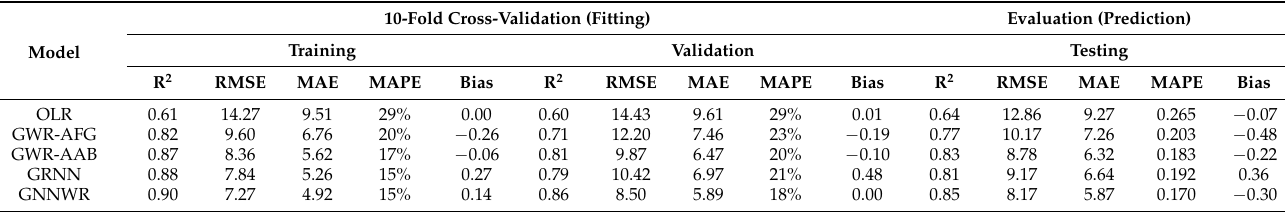
Figure 3. Histograms and descriptive statistics of the experimental datasets. The green color represents the smaller 25% data, the yellow color represents the middle 50% data, and the red color represents the larger 25% data. Table 1. The 10-fold cross-validation and external evaluation performance of PM 2.5 estimations for OLR, GWR, GRNN, and